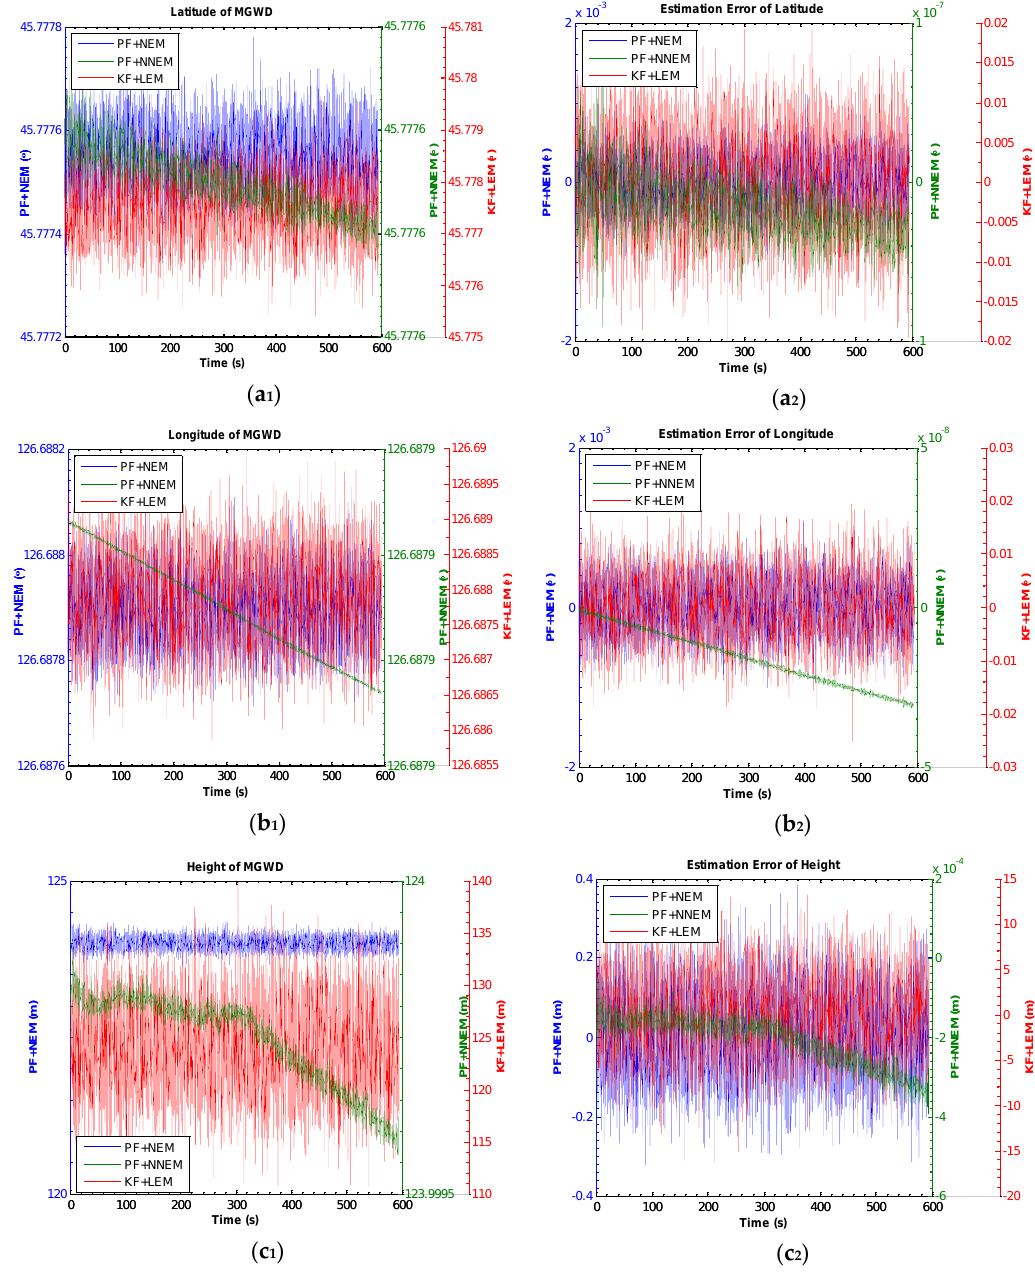
Figure 12. Results of estimation of position and estimation error of position by KF with LEM, PF with NEM, and PF with NNEM under large-angle attitude error condition. ( a 1 ) and ( a 2 ) are the estimation of latitude and estimation error of latitude; ( b 1 ) and ( b 2 ) are the estimation of longitude and estimation error of longitude; ( c 1 ) and ( c 2 ) are the estimation of height and estimation error of height.